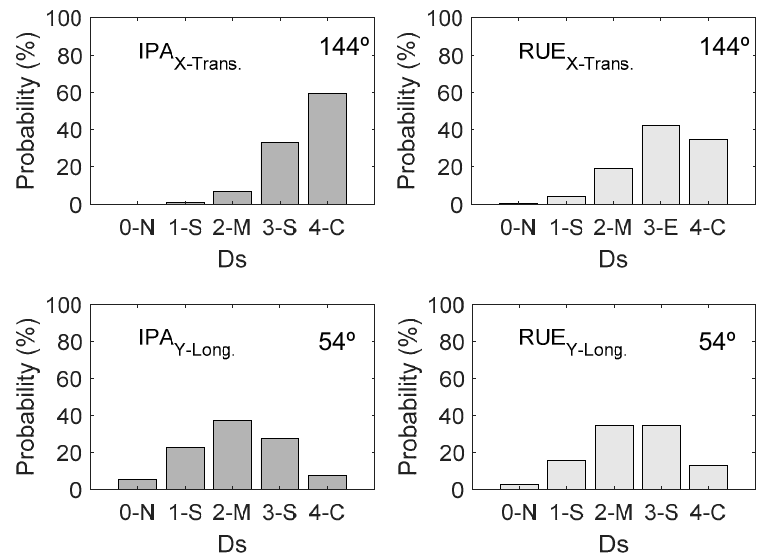
Figure 19. Damage probability matrices for the two main axes of the building (54° and 144° approximately) and for the two hypotheses used to define the damage states’ thresholds.